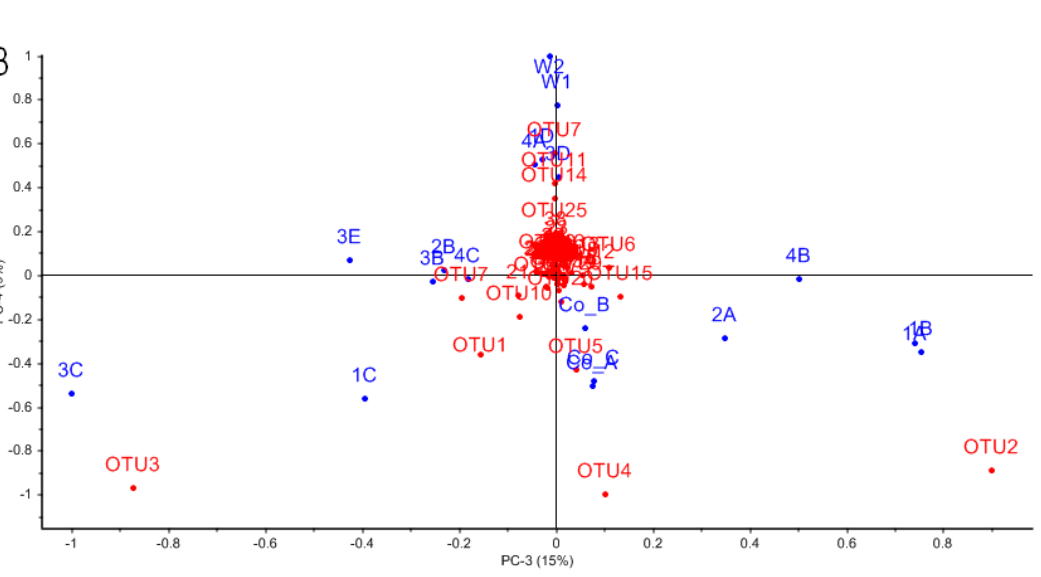
Figure 5. PCA biplots describing species level OTUs responsible for the observed variance between A. elisabethae and seawater bacterial communities. Red circles labeled with “OTU” numbers represent OTUs. Blue circles represent A. elisabethae and seawater bacterial communities. PC1 and − 2 ( A ) describe 50% and 19% of the observed variance, respectively. PC3 and − 4 ( B ) describe 15% and 8% of the variance, respectively. Collectively PC1–4 explains 92% of the total variance.